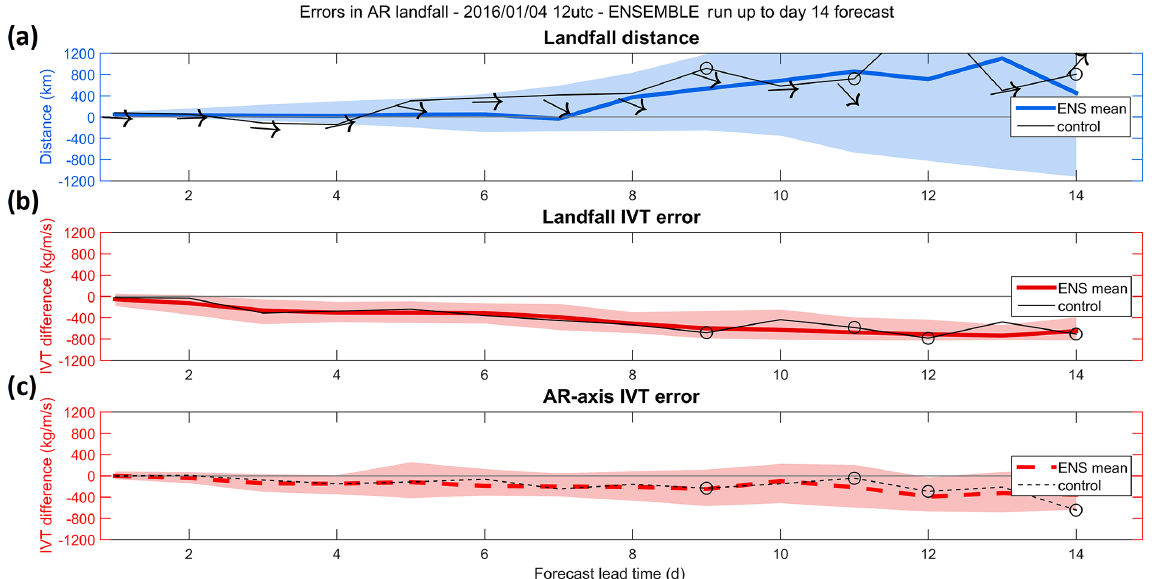
Figure 4. Example of the evolution with lead time for the accuracy of IVT probabilistic forecasts is shown for the event presented in Fig. 3. In (a) the black line represents the error in the location of the maximum IVT (i.e., landfall distance) in the control run (in kilometers), while the solid blue line represents the landfall distance for the ensemble forecasts. The shaded blue envelope shows the ensemble spread, considering the 25th and 75th percentiles. In addition, the black arrows represent the errors in the angle (in degrees) of the AR axis for each forecast. Panel (b) shows the error in the IVT intensity (kgm − 1 s − 1 ) for each forecast at the observed landfall location. The solid black line, solid red line, and shaded red envelope are as in (a) . Panel (c) shows the error in the maximum IVT at the specific locations where it has been observed and forecasted for each lead time, regardless of the landfall distance. The dashed black line, dashed red line, and shaded red envelop as and (b) . The open circles represented in some lead times represent forecasts where the maximum IVT did not surpass a minimum threshold of 450kgm − 1 s − 1 within the target domain (i.e., regional boxes over western